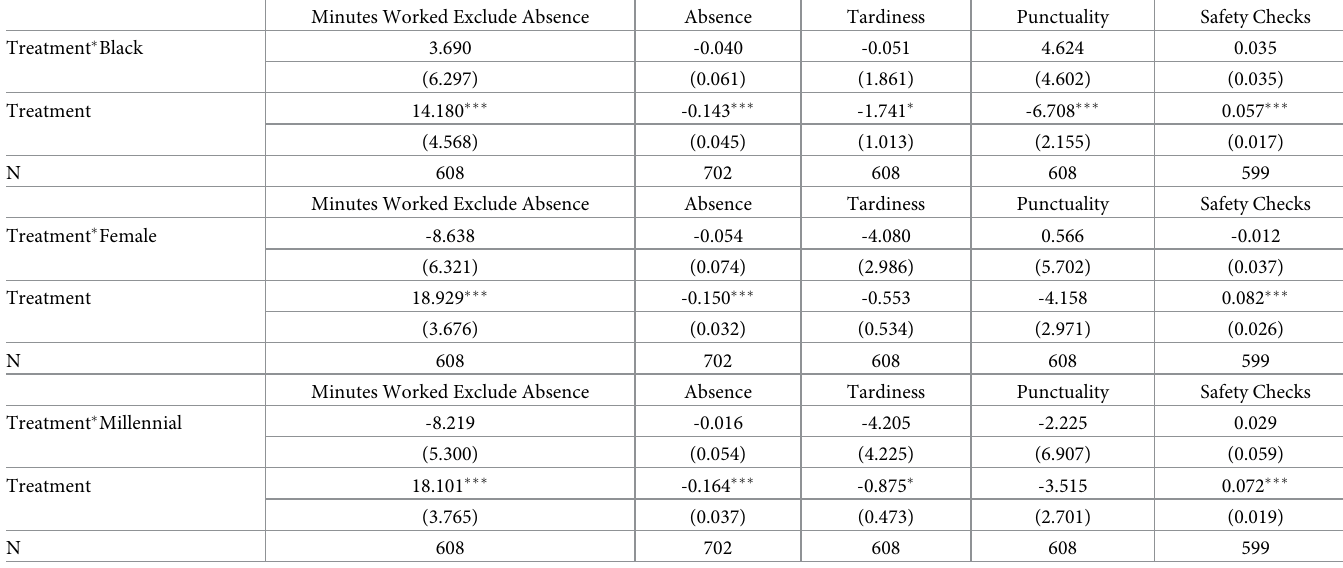
Table 3. Fixed effects estimates with interactions. (ex post +9 days).